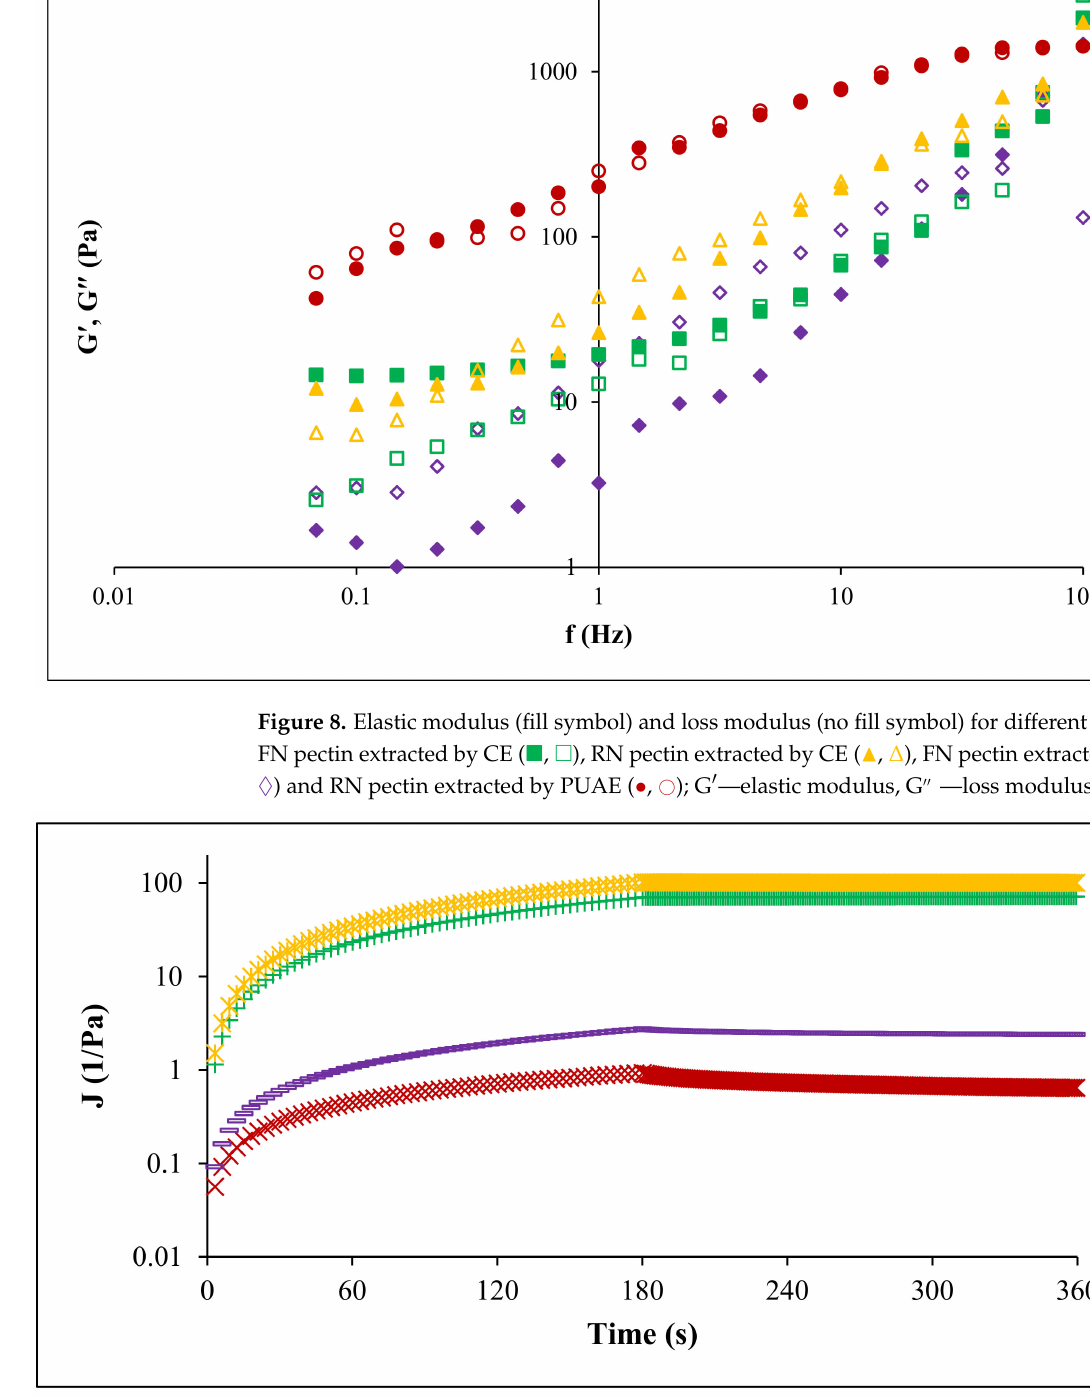
Figure 9. Creep and recovery test of pectin solutions: FN pectin extracted by CE ( + ), RN pectin extracted by CE ( ж ), FN pectin extracted by PUAE ( × ) and RN pectin extracted by PUAE ( – );